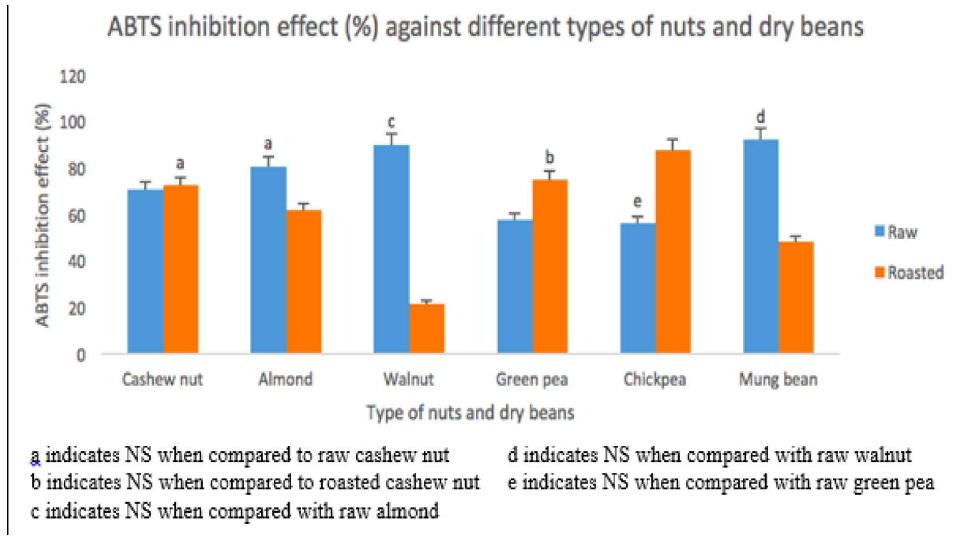
Fig. 2. ABTS inhibition effect (%) in raw and roasted dry beans and